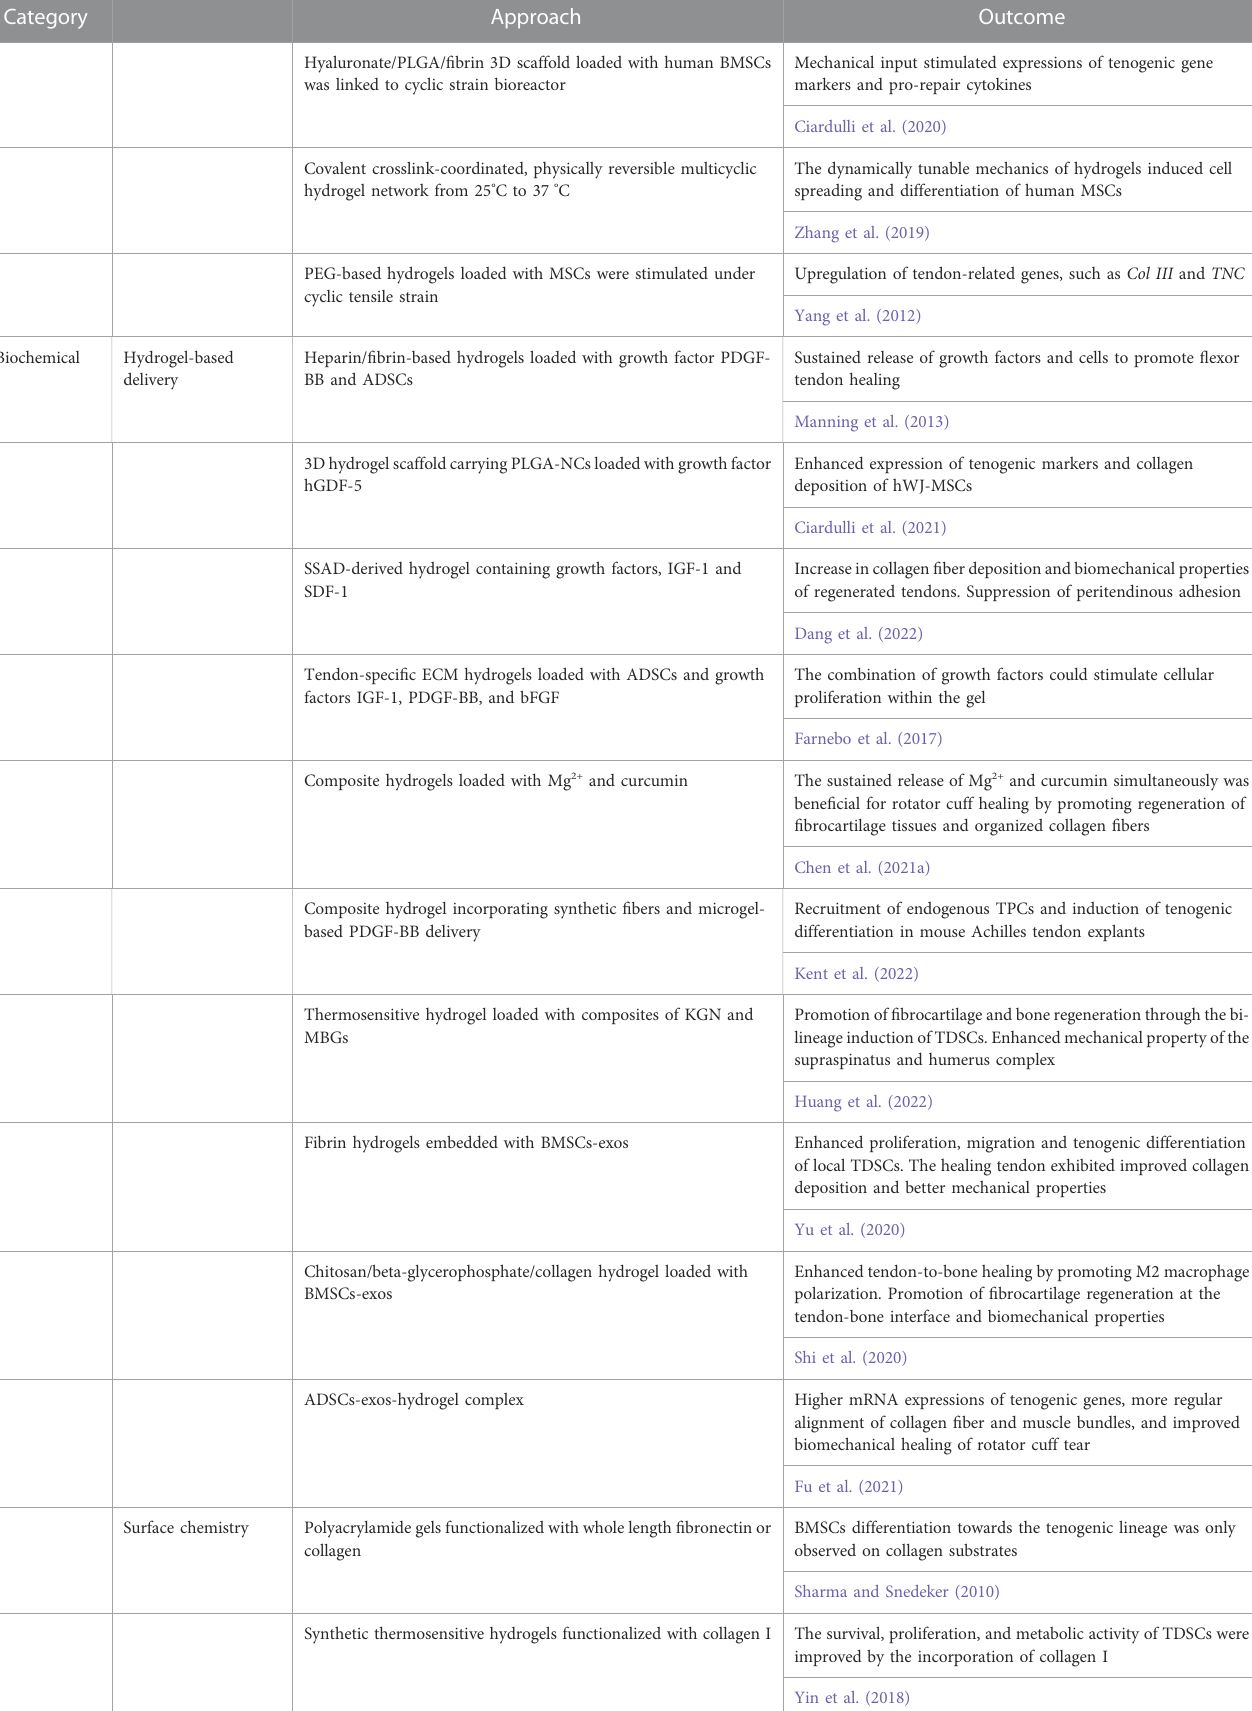
TABLE 2 ( Continued ) Tuning biophysical and biochemical factors of hydrogels for stem